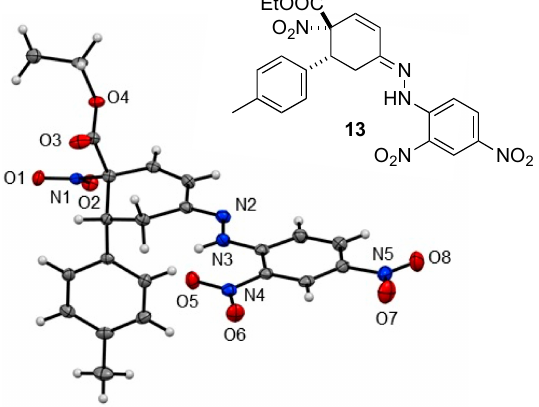
Figure 1. The crystal structure of 13 with ORTEP drawing (50% probability). Atoms are colored as follows: carbon, gray; nitrogen, blue; oxygen, red. Triclinic, P -1, Z = 2, GOF = 1.062, R 1 [ I > 2 σ ( I )] = 0.0369, wR 2 (all data) = 0.1055.